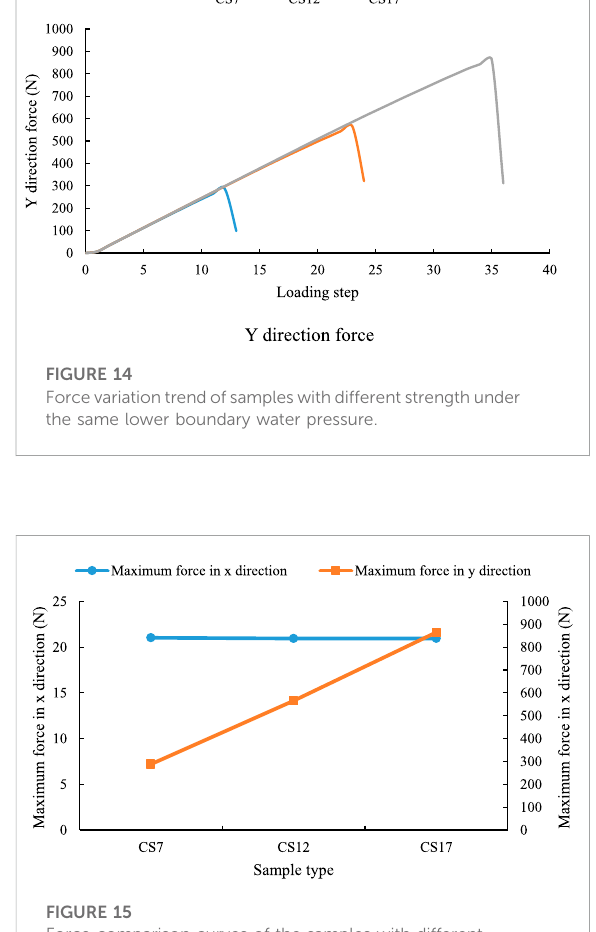
FIGURE 15 Force comparison curves of the samples with different strengths under the same lower boundary water